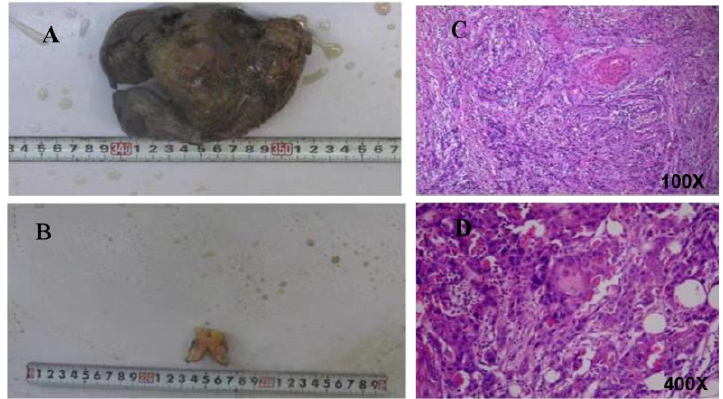
Figure 1. Pathology images of postoperative tissues after recurrence. Picture of penis tumor tissue ( A ) and abdominal wall tumor tissue ( B ); H and E staining of penis tumor tissue sample ( C ) and abdominal wall tumor tissue sample ( D ).